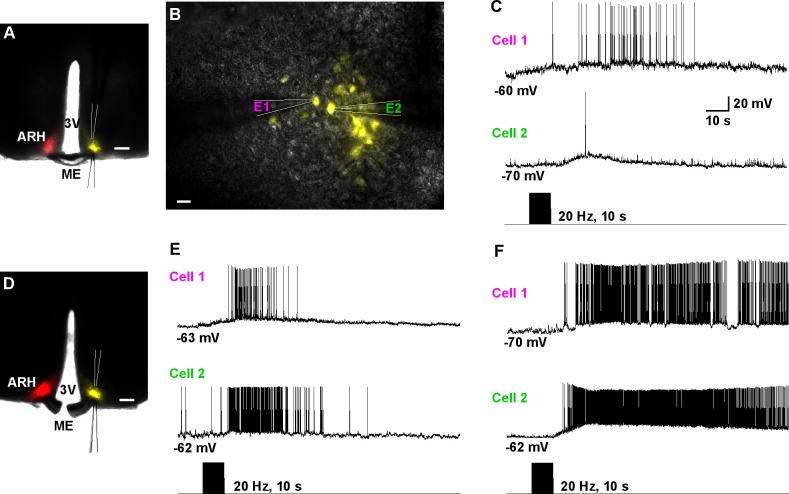
Dual patch recording reveal that high-frequency auto-excitation of ipsilateral Kiss1ARH neurons recruit contralateral Kiss1ARH neurons.(A) Image of a coronal section through the ARH from Kiss1-Cre mouse that received dual injection of AAV-DIO-ChR2:mCherry (left side, red) and AAV-DIO-YFP (right side, yellow). Scale bar = 200 µm. (B) DIC and fluorescent image (YFP) of dual patch recording from Kiss1ARH neurons in the contralateral ARH; whole cell recordings were made with electrode 1 (E1) and electrode 2 (E2) in the current-clamp mode. Scale bar = 20 µm. (C) High-frequency photostimulation induced a simultaneous increase in firing and a slow EPSP in a pair of Kiss1ARH neurons (Cell 1 and Cell 2) recorded in the contralateral ARH. (D), Image of a coronal section through the ARH from Kiss1-Cre mouse that received dual injection of AAV-DIO-ChR2:mCherry (left side, red) and AAV-DIO-YFP (right side, yellow). In this slice, the ME was cut to disconnect the two sides. Scale bar = 200 µm. (E and F) Examples of synchronized activity obtained using dual patch recording from two pairs of Kiss1ARH neurons in the contralateral ARH (D). ARH, hypothalamic arcuate nucleus; ME, median eminence; 3V, third ventricle.